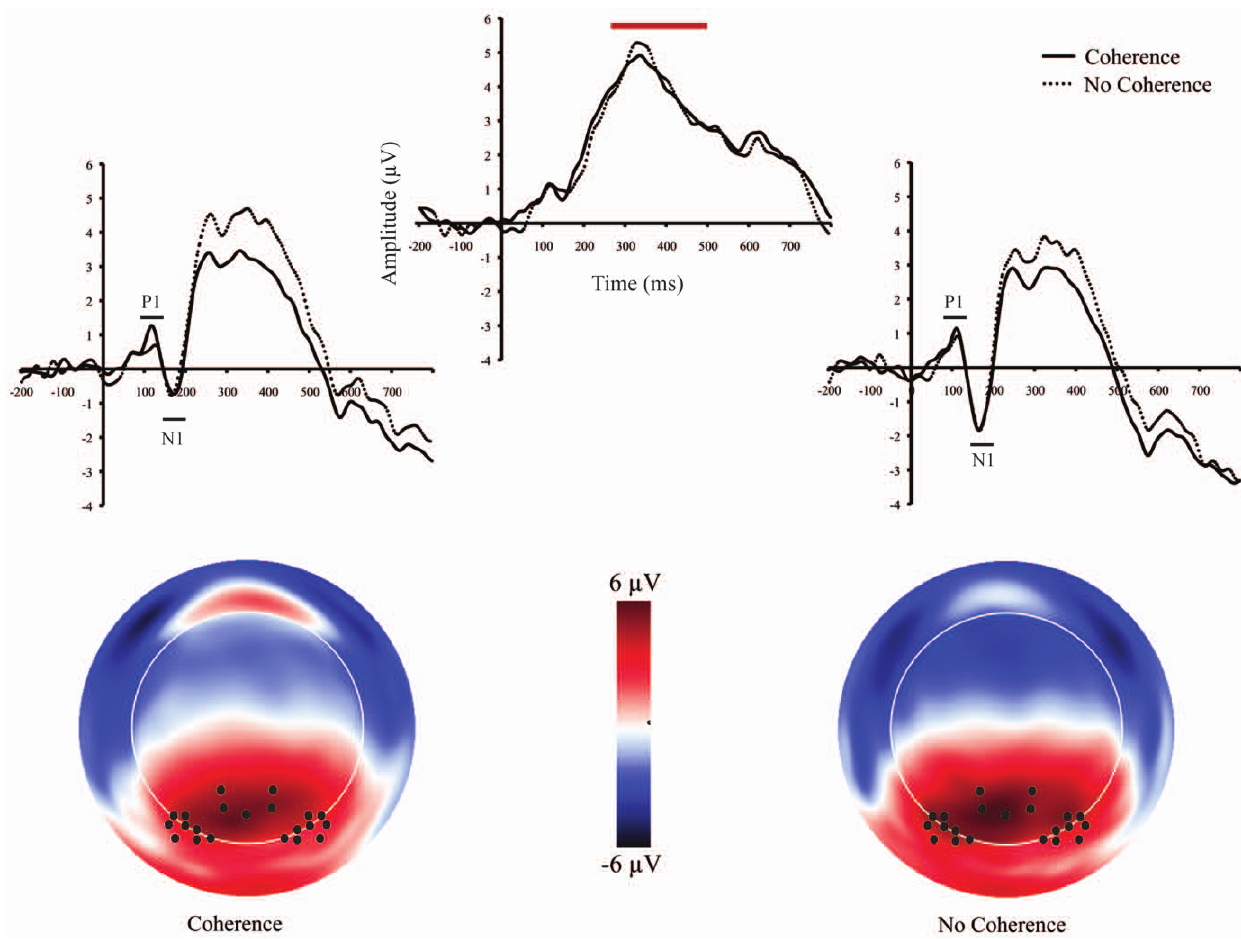
Figure 3. ERP waveforms and topographic maps. Top: Grand-average ERP waveform averaged across channel groups (indicated by black dots on the topographic maps on bottom). P1 and N1 components are demarcated by black lines and P3 component is demarcated by red line. Bottom: Topographic maps at the peak of the P3. Black dots represent location of channels used to form the average waveforms. View of map is top looking down with nose towards top of image. Coherence = rated coherence for fragmented images; No Coherence = rated no coherence for scrambled images.